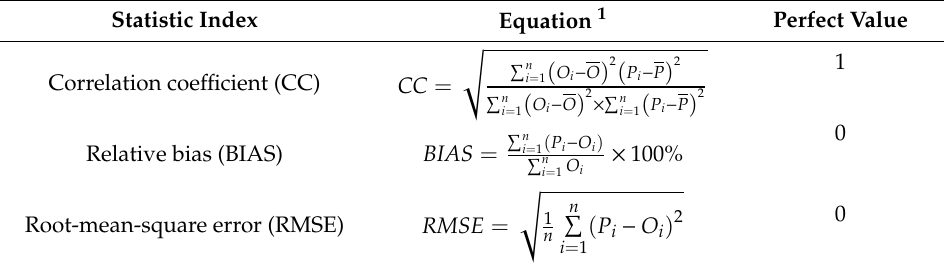
Table 3. Equations and the best values of three statistical